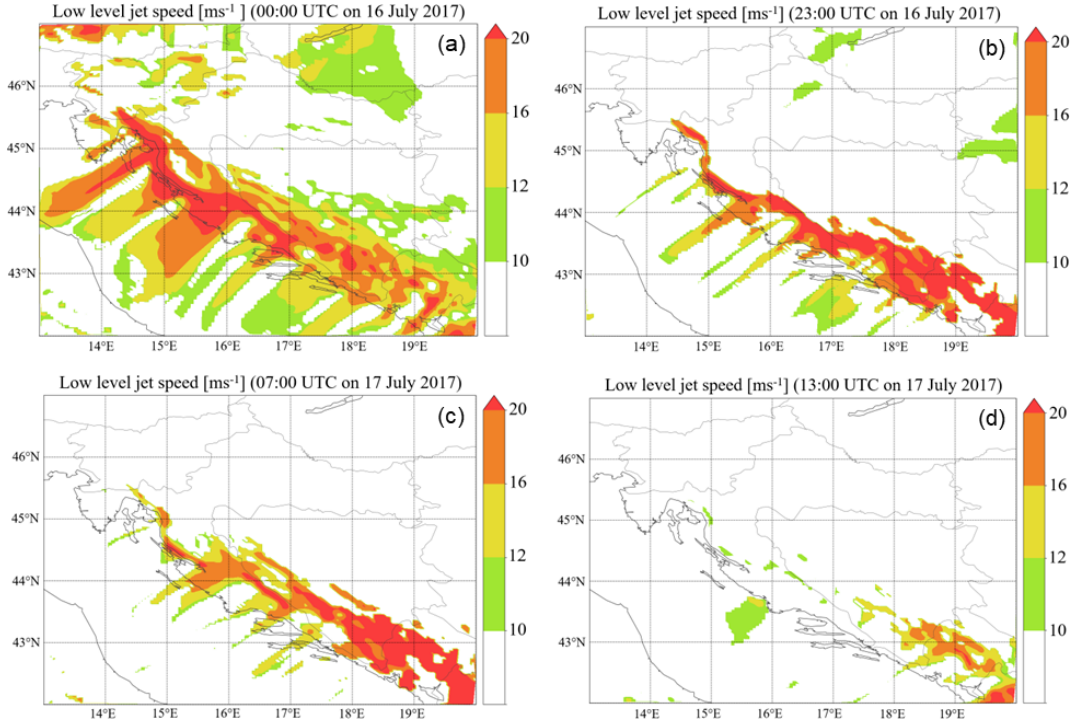
Figure 15. Spatial distribution of a low-level jet defined by criterion 0 to 3 (ms − 1 ) at (a) 00:00UTC on 16 July 2017, (b) 23:00UTC on 16 July 2017 (SPLIT 1 period – ignition time), (c) 07:00UTC on 17 July 2017 (SPLIT 1 period – aircraft approach), and (d) 13:00UTC on 17 July 2017 (SPLIT 2 period) from the ALADIN-HR44